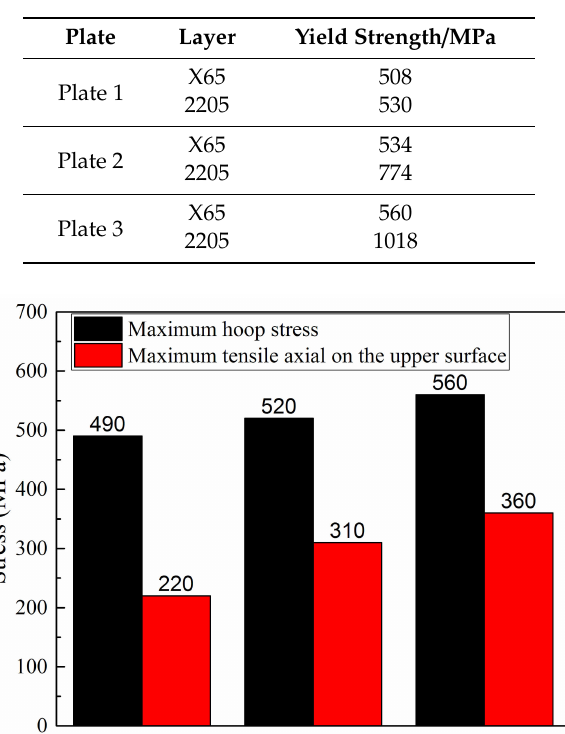
Table 4. Yield strength of the simulated plates.